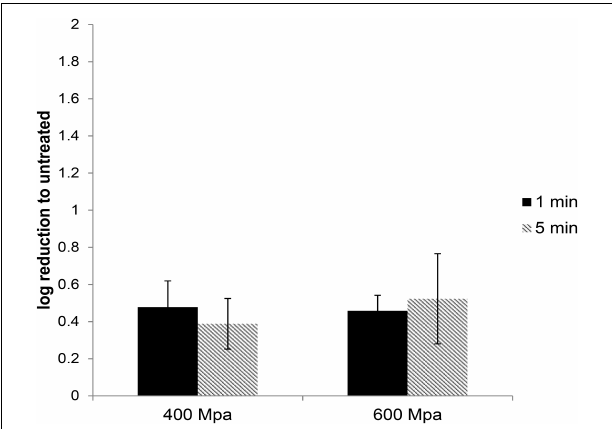
FIGURE 3 | The effect of HPP treatment on HEV-3c strain 47832c in ready-to-eat pork pâté. The samples containing 4 × 10 7 RNA copies of HEV were treated at 400 and 600 MPa for 1 and 5 min at ambient temperature in triplicates and were inoculated onto A549/D3 cells. The HEV genome copy numbers in the supernatant were quantified at 14 d.p.i. using ddRT-PCR. The effect is shown in comparison to the untreated but inoculated samples. Error bars represent standard deviation.